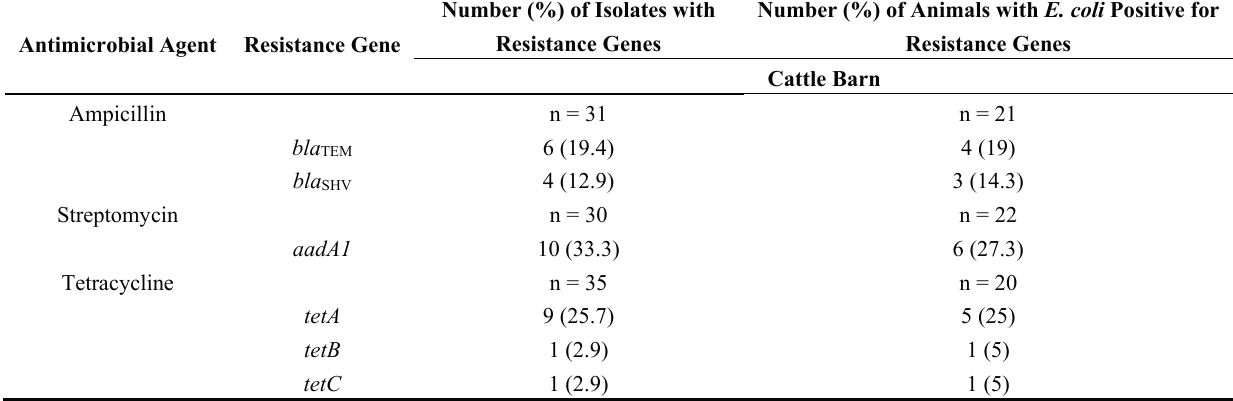
Table 3. Prevalence of the antimicrobial resistance genes among phenotypically resistant E. coli and among animals with resistant E. coli from dairy